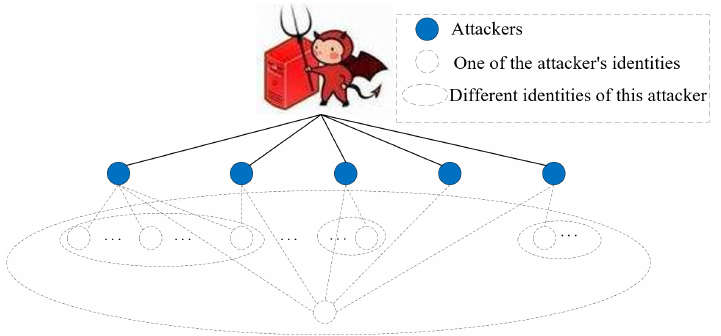
Figure 3. Network